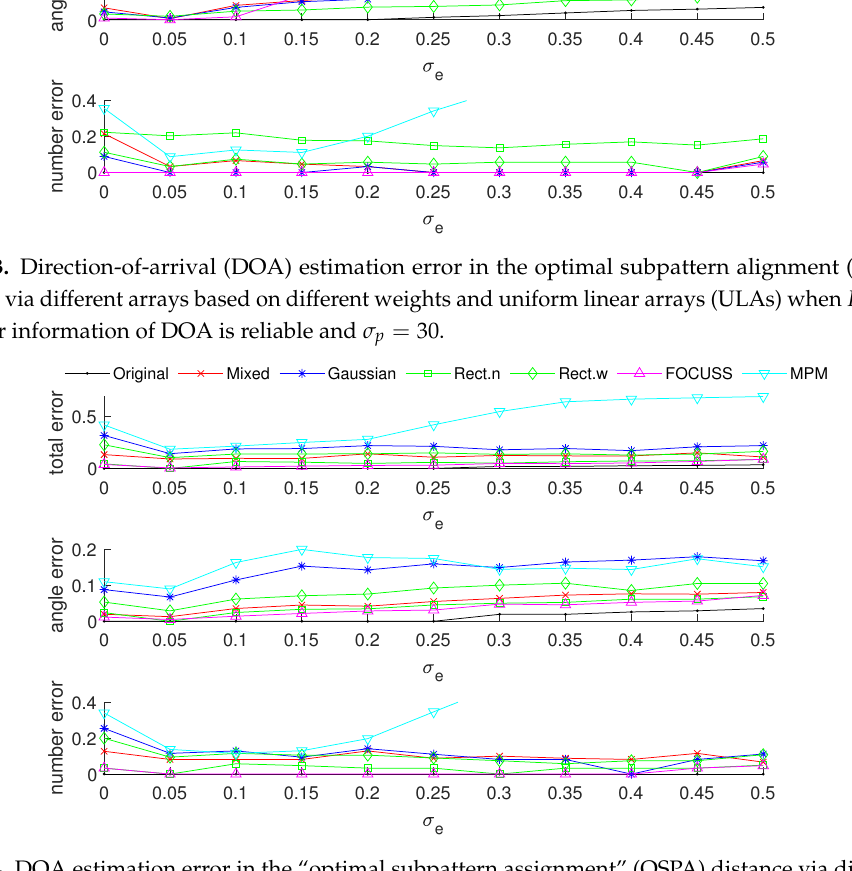
Figure 4. DOA estimation error in the “optimal subpattern assignment” (OSPA) distance via different arrays based on different weights and uniform linear arrays when K = 20; the prior information of DOA is reliable and σ p =